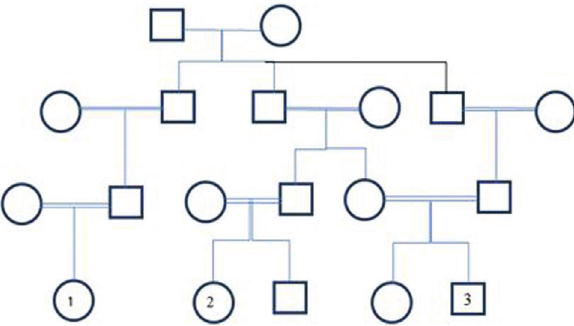
Figure 1 - Pedigree of the family with MLD patients. The patients are shown in the fourth generation with the numbers 1, 2 and 3. The parents of patient 1 are paternal or maternal first cousins. Also, the parents of the pa- tient 2 are first cousins once removed. It is of note that the information was provided by the parents of the patients. Genotypes of the patients and their parents are g.2207G>T (Hom) and g.2207G>T (Het) respectively.